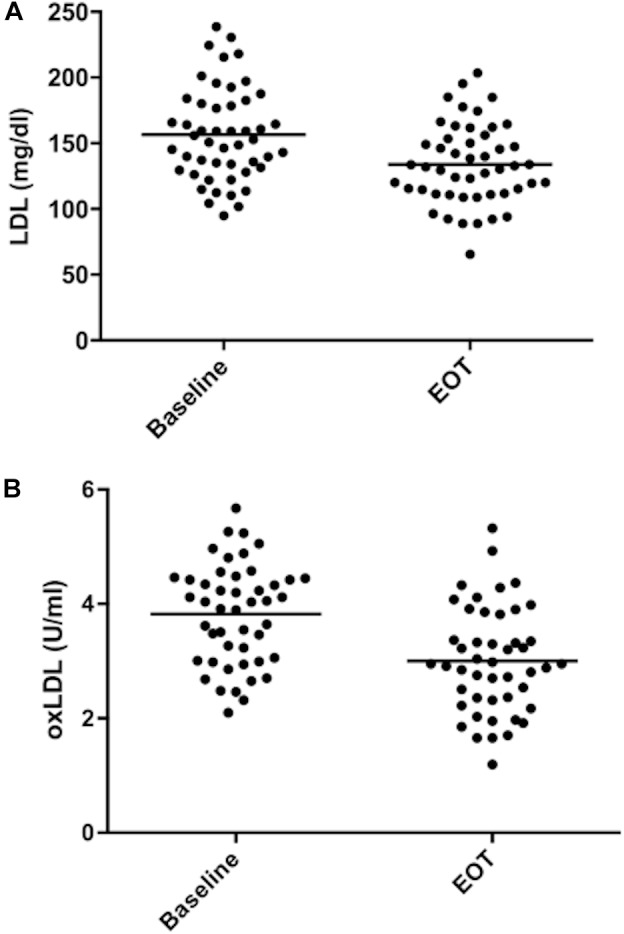
Low density lipoprotein and oxidized low density lipoprotein values during the study. (A) LDL values. (B) oxidized LDL values. Mean values are shown as bars. EOT, end of treatment.